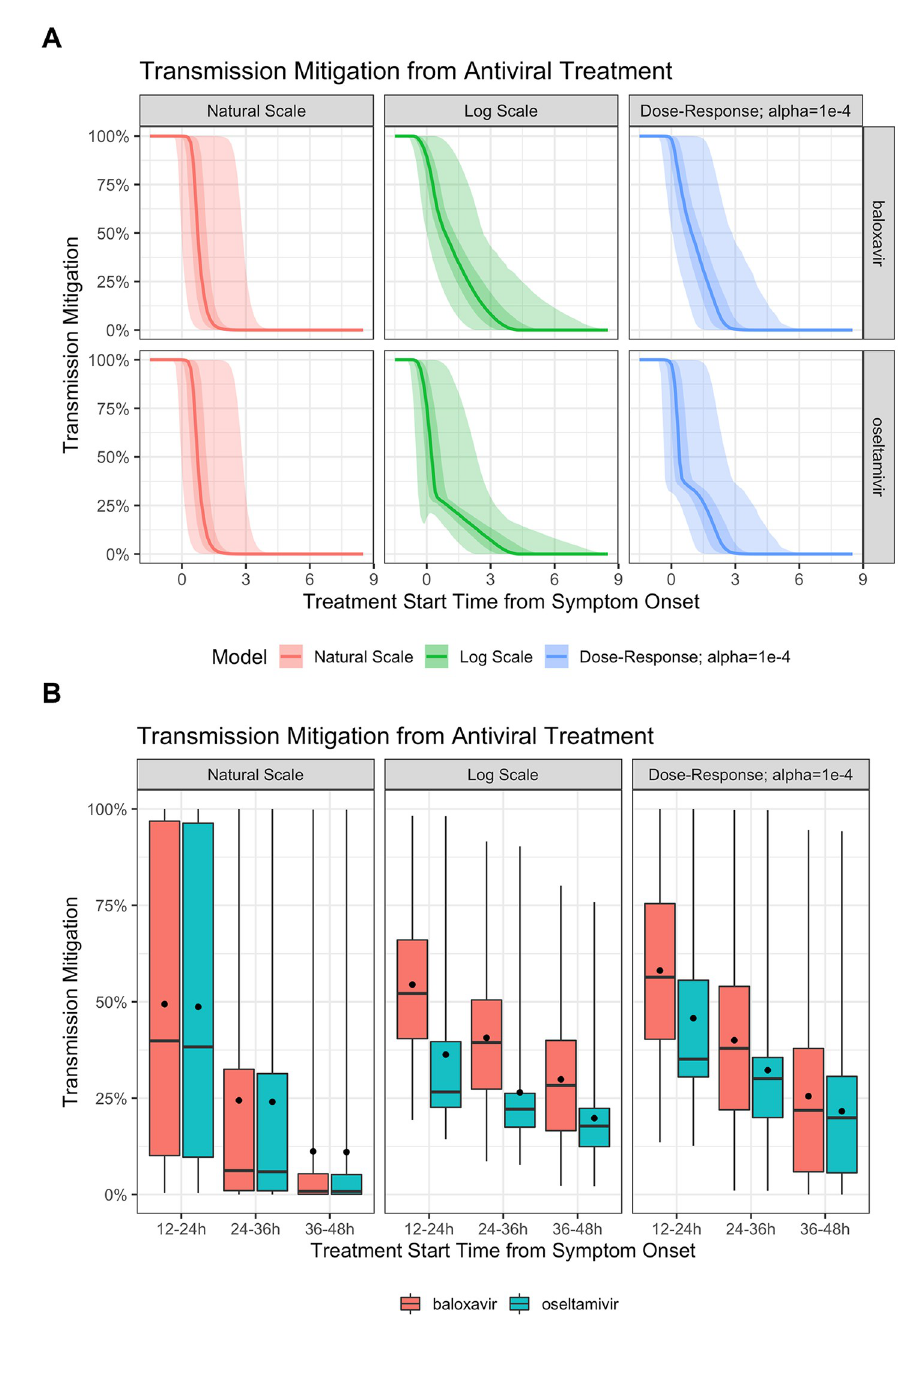
Fig 4. Estimated mitigation of influenza transmission by baloxavir and oseltamivir. Estimated mitigation of influenza transmission by baloxavir and oseltamivir according to treatment initiation time from symptom onset using natural-scale, log-scale, and dose–response models, with time presented on a continuous scale (A) or as discrete time intervals (B). Both figures show interindividual variability. (A) The line represents the median; lighter shaded areas correspond to the 95% confidence interval around this median, and darker shaded areas show the interquartile range. (B) The boxplots show median, interquartile range, and 95% confidence intervals; the dots correspond to the mean.